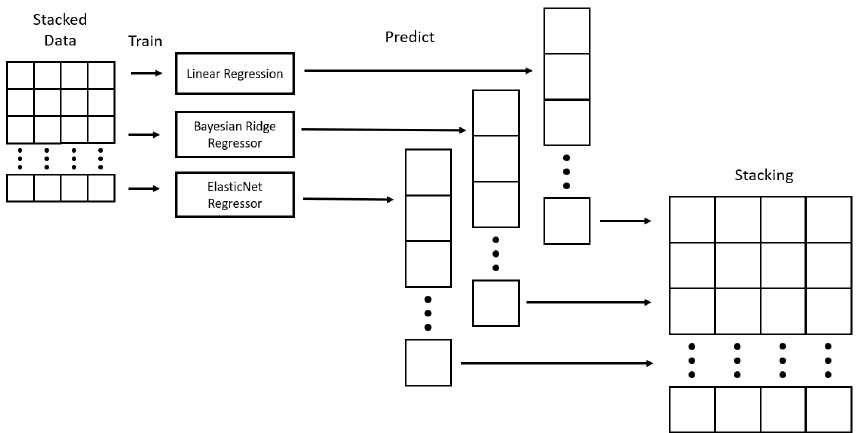
Figure 5. Summary graph for the second step of the stacking method: training dataset of final model is generated by metamodels in this step.